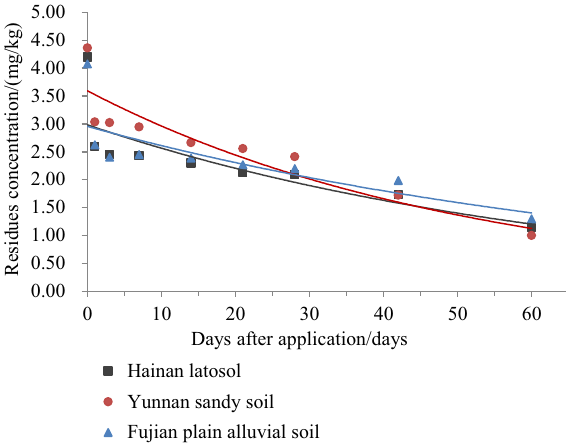
Figure 4. The dissipation trends of fluopyram in different banana planting soils.